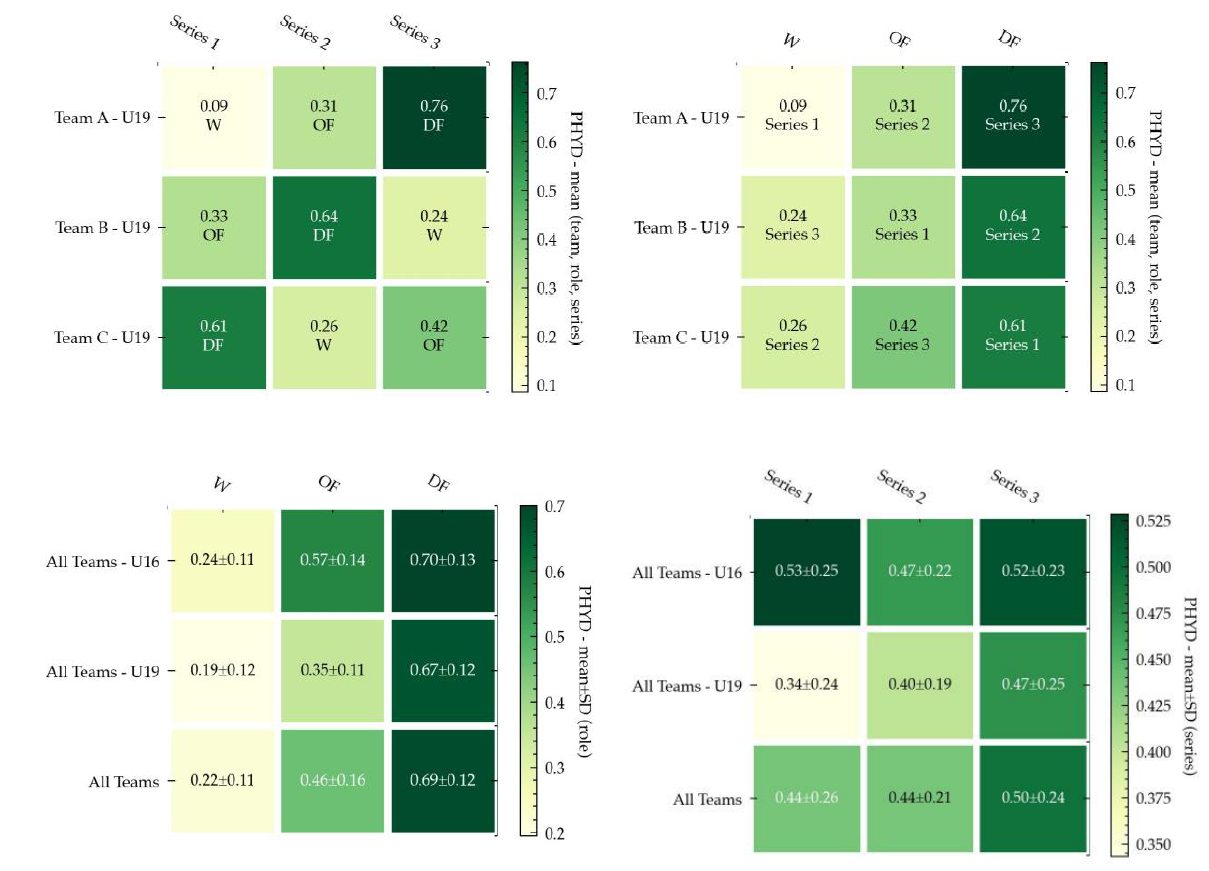
Figure 2. Annotated Heatmaps for the study of the PHYD variable (U16, U19, and datasets merged). Note: The following figure presents six heatmaps for the study of physical demands in the three datasets studied, in which first row shows U16 results, the second shows U19 results, and the third shows merged dataset results. The three heatmaps in the left column focus on the comparison among roles (OF, DF, and W), while heatmaps in the right column focus on the comparison among series (Series 1, Series 2, and Series 3). Dark colors show a higher PHYD rate, whereas the light color indicates less prevalence.